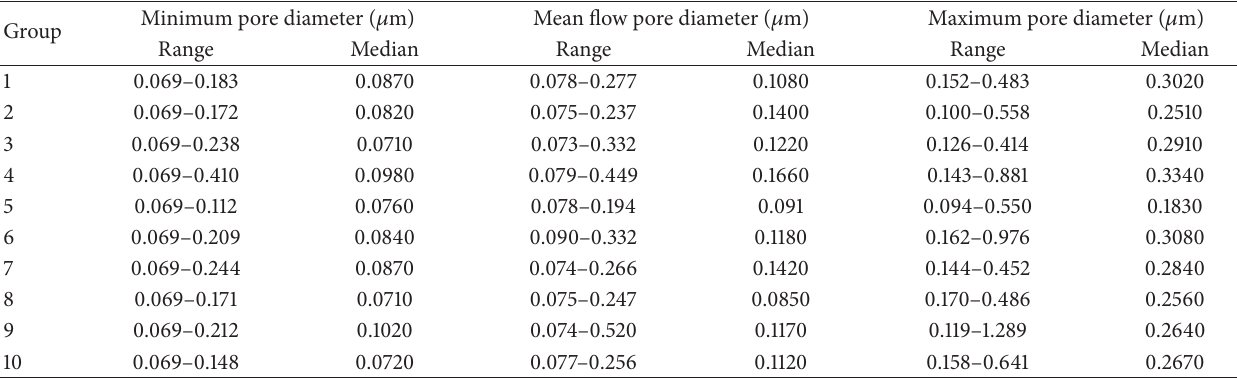
Table 2: Range and median of minimum, mean flow, and maximum pore diameters by root end filling material at 48h (groups 1 to 5) and then immediately after root resection (groups 6 to